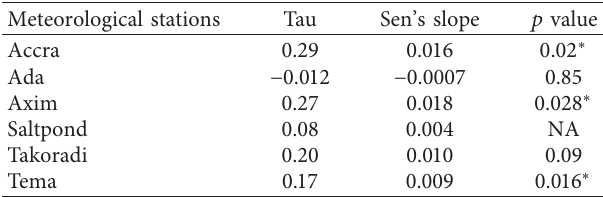
Table 4: NDJ SPI Mann–Kendall test.